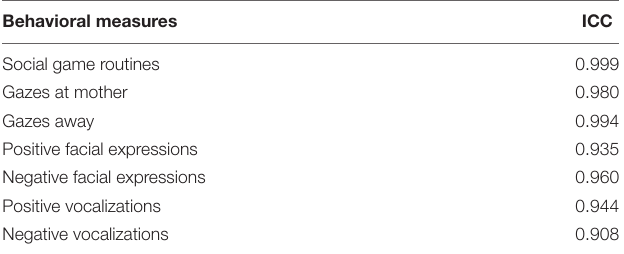
TABLE 2 | Inter-rater reliability computed as intra-class correlations (ICC) for all behavioral measures.